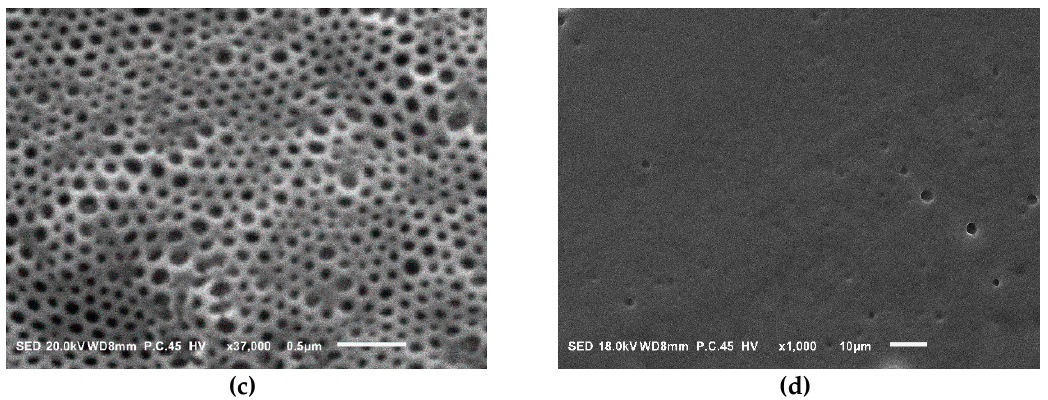
Figure 5. SEM images of BF films produced from first generation LDBCs with hydroxyl end groups: ( a , b ) deLG1-PSt 11k; ( c ) deLG1-PSt 8.5k; ( d ) deLG1-PSt 4.9k. Scale bars: ( a ) 2 µ m; ( b , c ) 0.5 µ m; ( d ) 10 µ m.